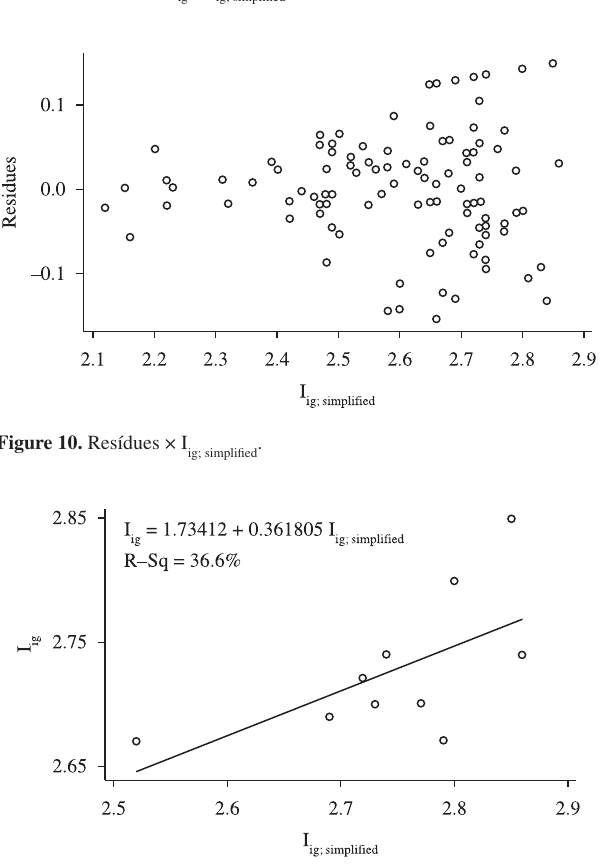
Figure 9. Regression I